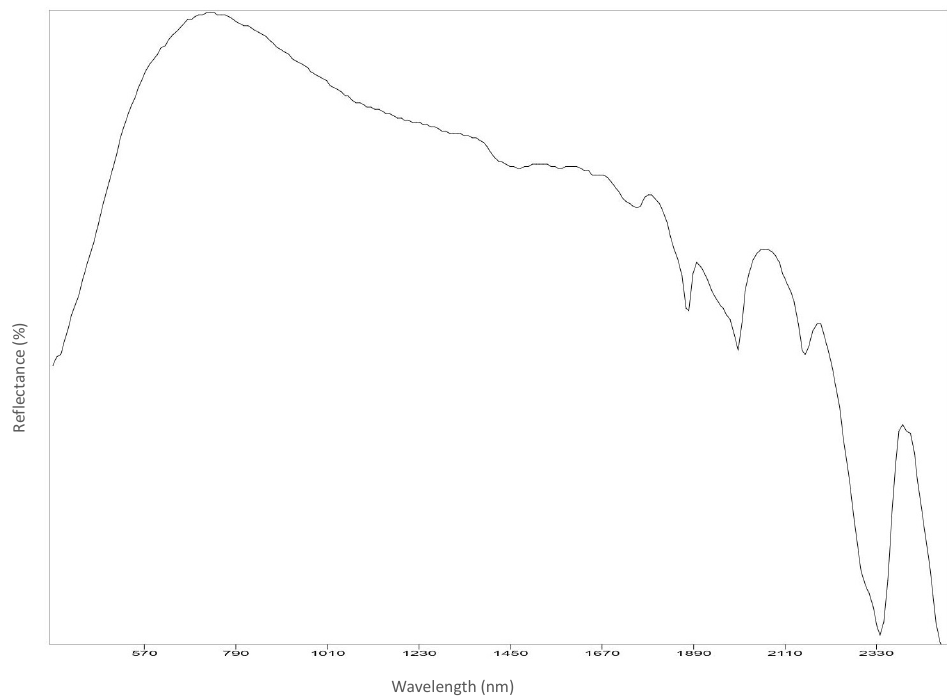
Figure A8. Back-right.